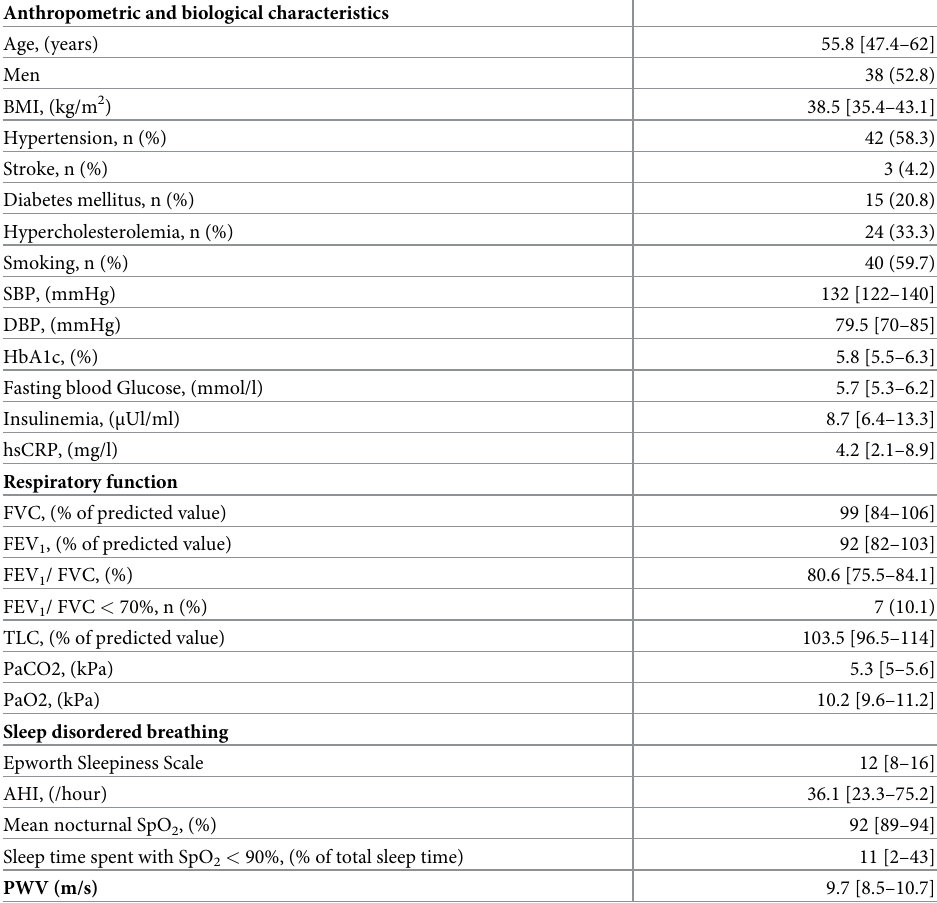
Table 1. Study population characteristics at baseline.